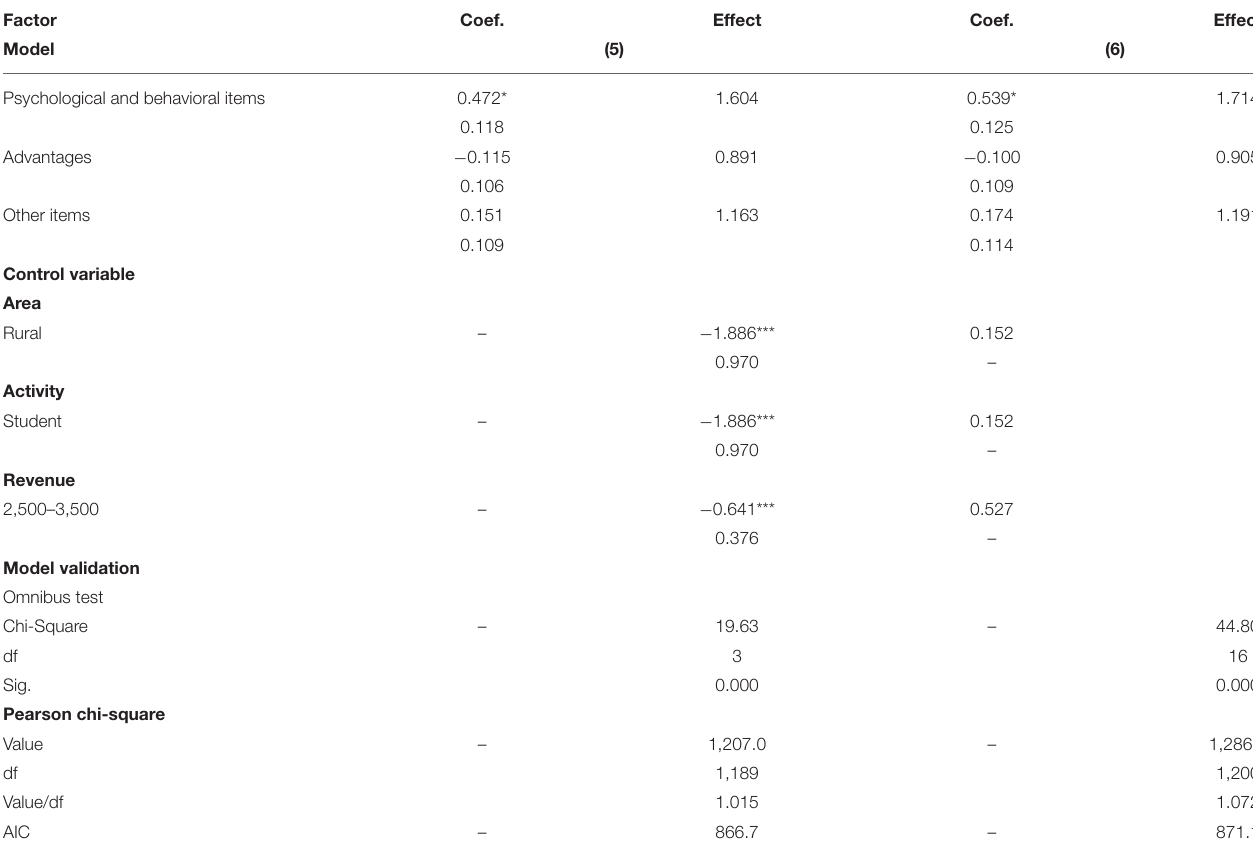
TABLE 12 | GLM regression model